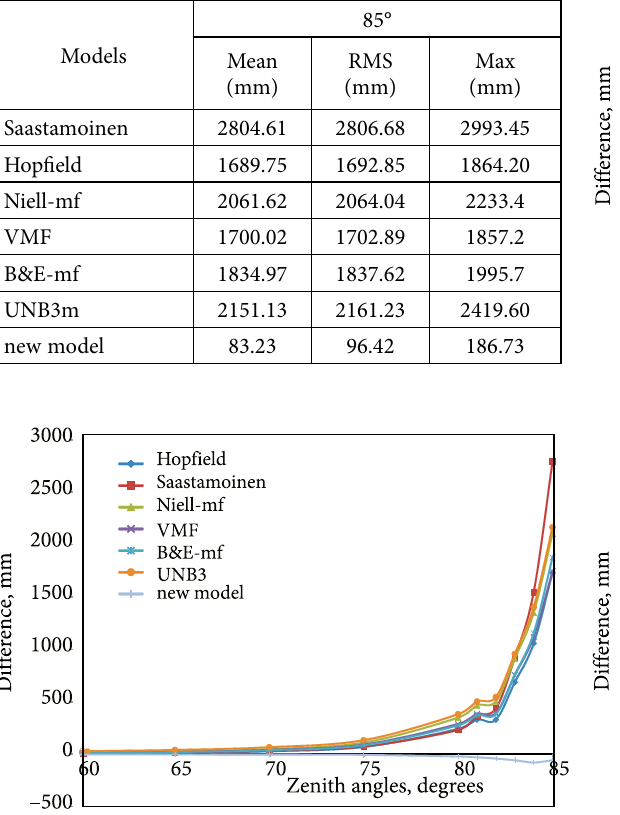
Fig. 3. Difference in mm for Mersa-Matrouh station,